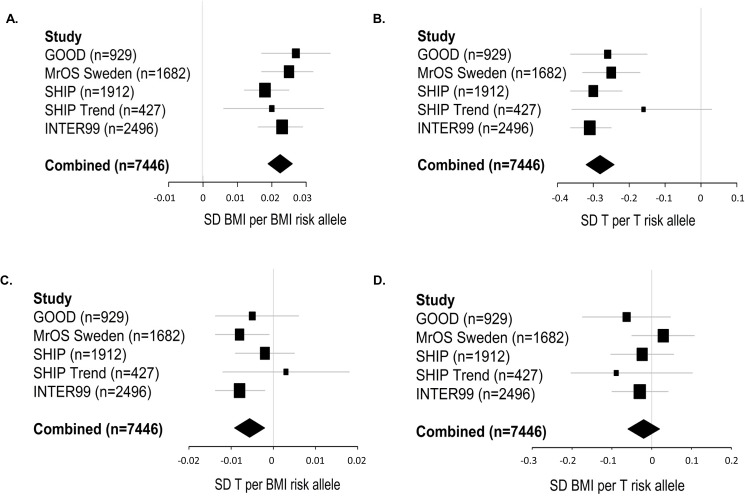
The genetic risk scores’ association with BMI and serum T.A) High weighted genetic risk score on BMI (wGRSBMI) is associated with high BMI. B) The weighted genetic risk score on serum testosterone (T; wGRST) is inversely associated with serum T. C) The weighted genetic risk score on BMI (wGRSBMI) is inversely associated with serum testosterone (T). D) The weighted genetic risk score on serum T (wGRST) is not associated with BMI. Linear regression models were used adjusting for age, smoking, site and time of day for blood sample, when applicable. The combined effect was calculated with fixed-effect meta-analysis (A: I-squared = 0%, p = 0.63; B: I-squared = 0%, p = 0.49; C: I-squared = 0%, p = 0.51; D: I-squared = 0%, p = 0.62) using all cohorts (n = 7446). Effect sizes are given in standard deviations (SD) of ln-transformed BMI per weighted BMI risk allele in A, SD of T per weighted T risk allele in B, SD of T per weighted BMI risk allele in C and SD of ln-transformed BMI per weighted T risk allele in D. Horizontal bars represent 95% confidence intervals.